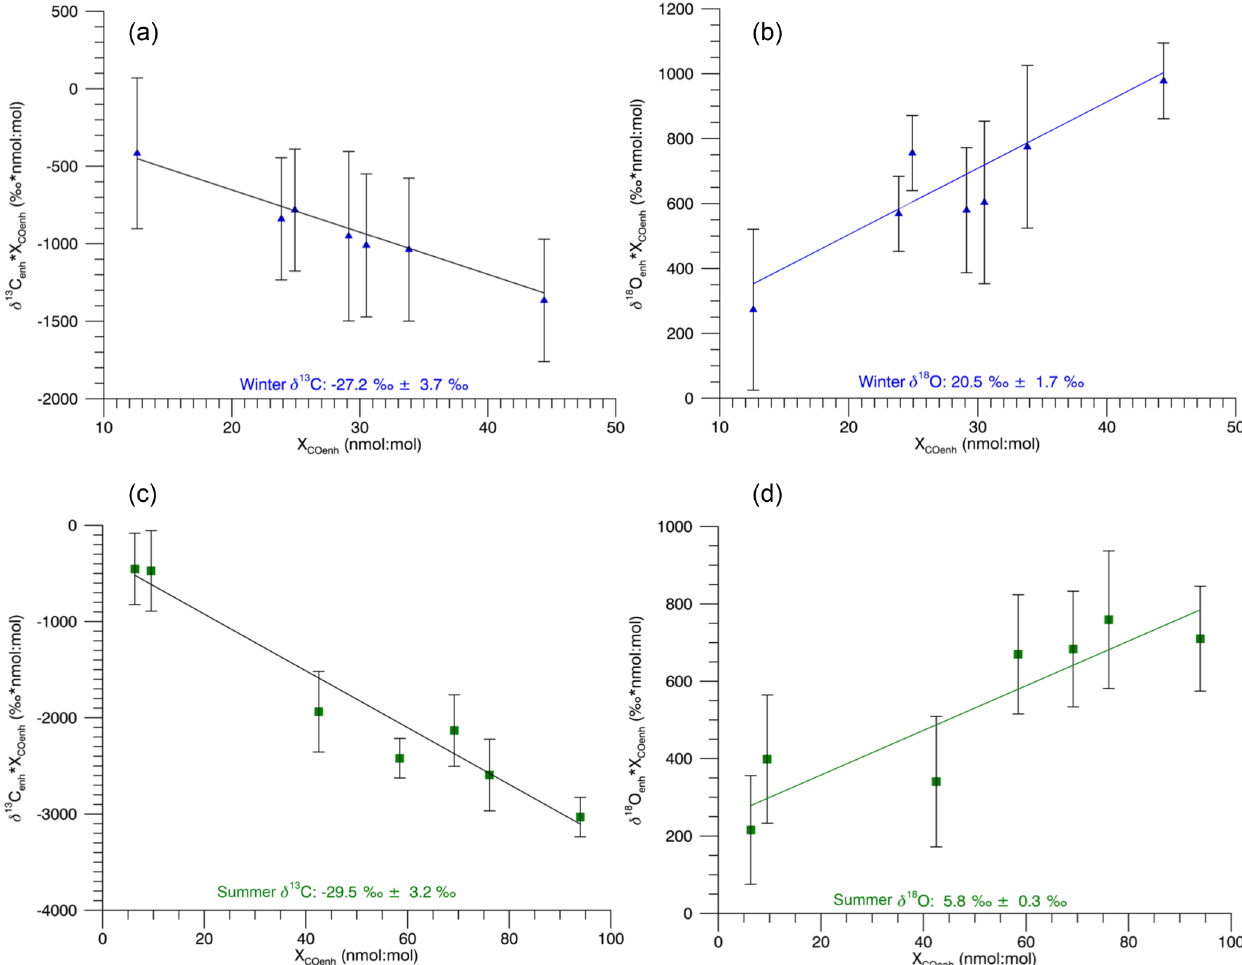
Figure 6. Miller–Tans analysis of Beech Island seasonal source signatures using monthly means from Izaña, Tenerife (Bräunlich, 2000), for background values. Green squares indicate summer data and blue triangles indicate winter data. The δ 13 C and δ 18 O values reported are the mean of 10000 regression slopes from our Monte Carlo simulation (Sect. 2.5). The uncertainty is the standard deviation of the 10000